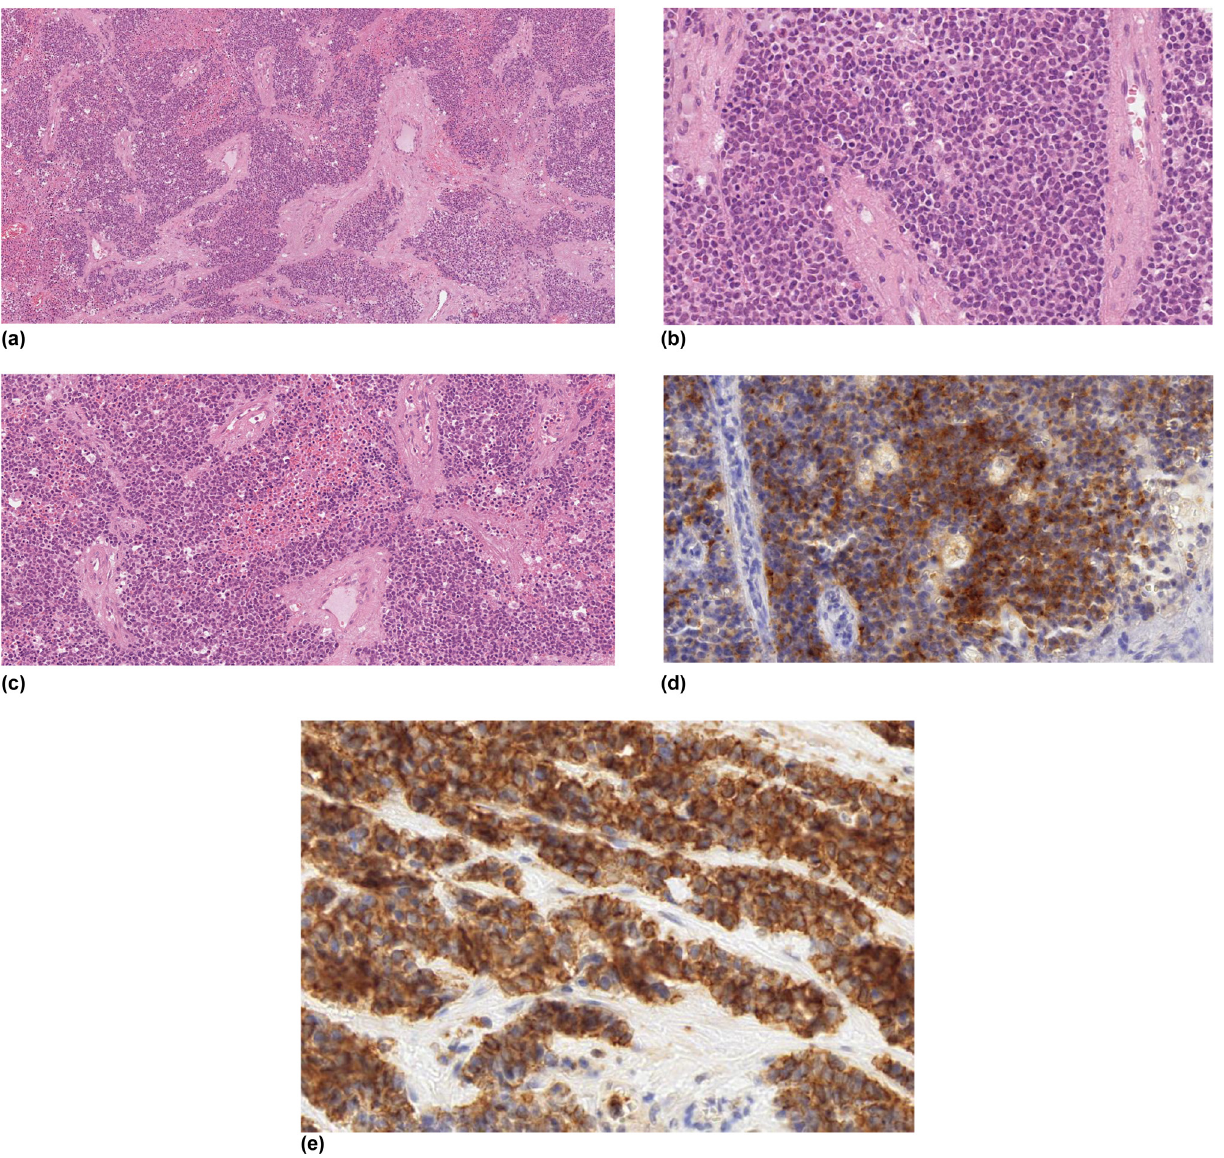
Figure 5: Histologic fi ndings ( a – e ) revealed EES appearing as a poorly di ff erentiated, small round blue cells tumor positive for the transmembrane glycoprotein CD99, vimentin, and CD 117 staining. Hematoxylin and eosin staining ( a – c ) show the lesion composed by small to medium - sized cells arranged in nodules separated by sclero - hyaline septa. Synaptophysin marker ( d and e )